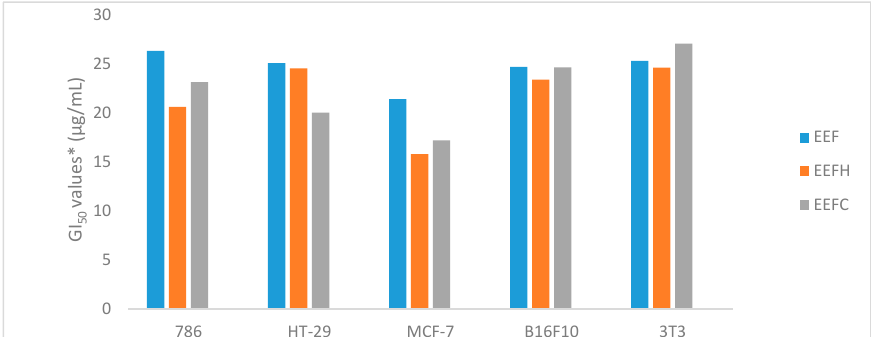
Figure 4. Cytotoxic activity, GI 50 values* ( µ g / mL) for extracts and fractions of fruits of Garcinia gardneriana , lines 786 (kidney carcinoma), HT-29 (colon carcinoma), MCF-7 (breast carcinoma), B16-F10 (murine melanoma), and NIH / 3T3 (murine fibroblast). * Concentration that inhibits 50% of cell growth